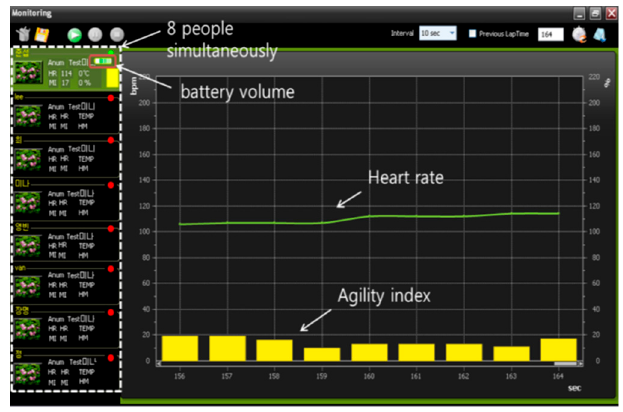
Figure 9. Screen shot of the monitoring interface.